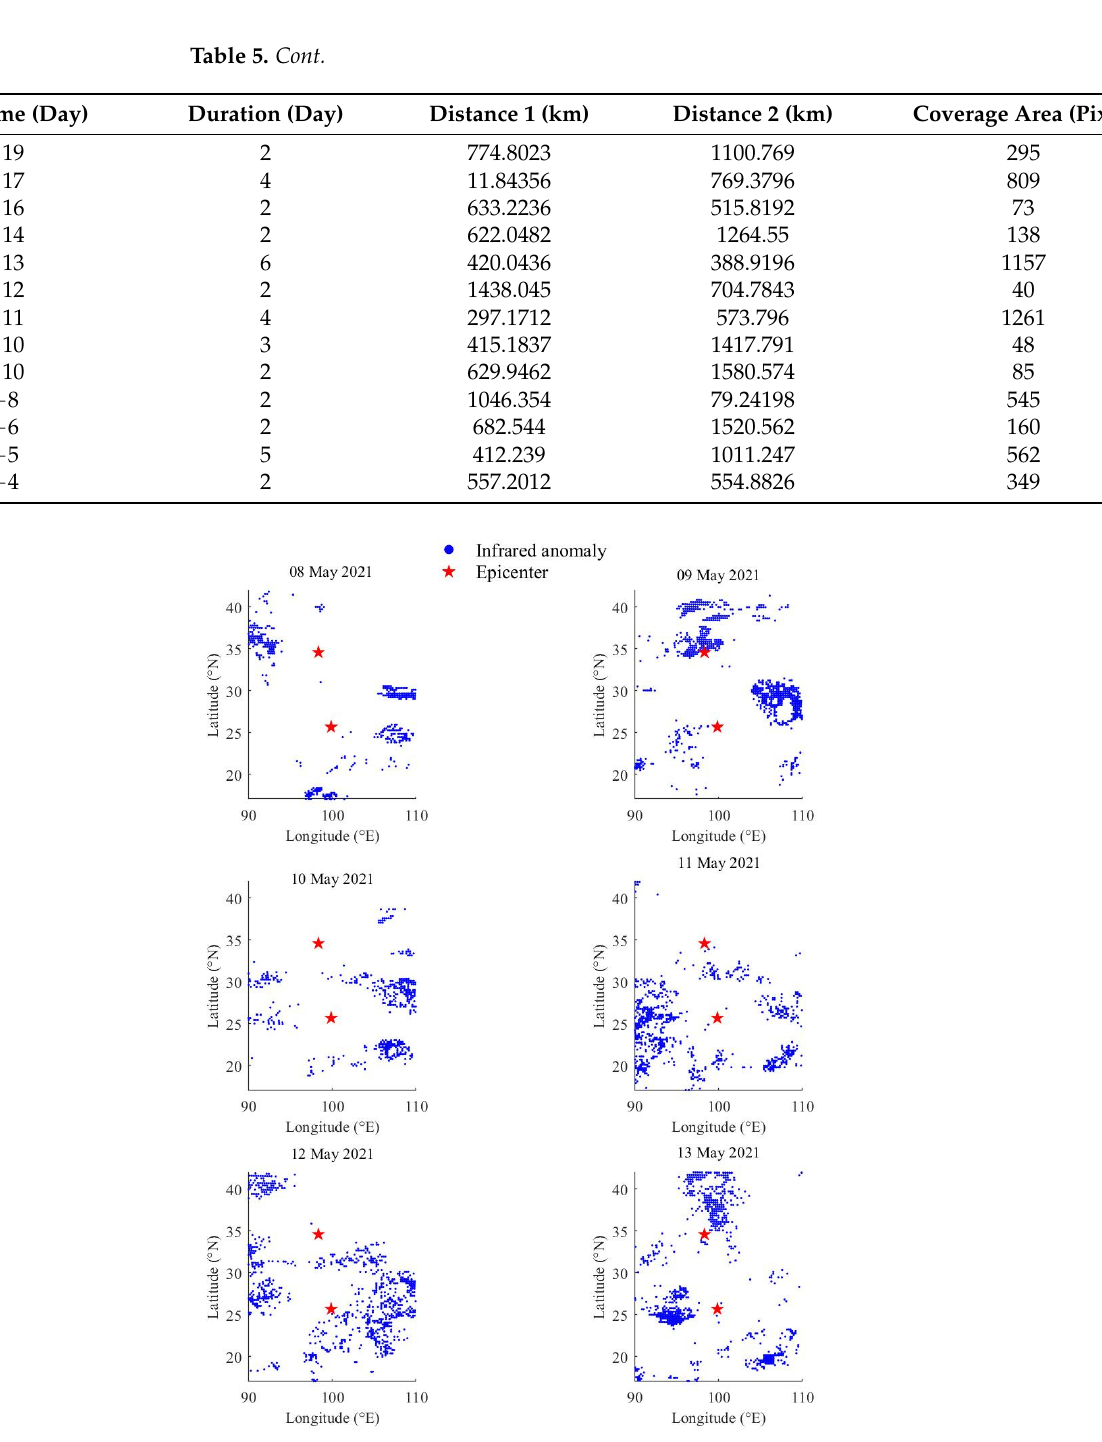
Figure 8. The anomaly images from 8 to 13 May 2021.